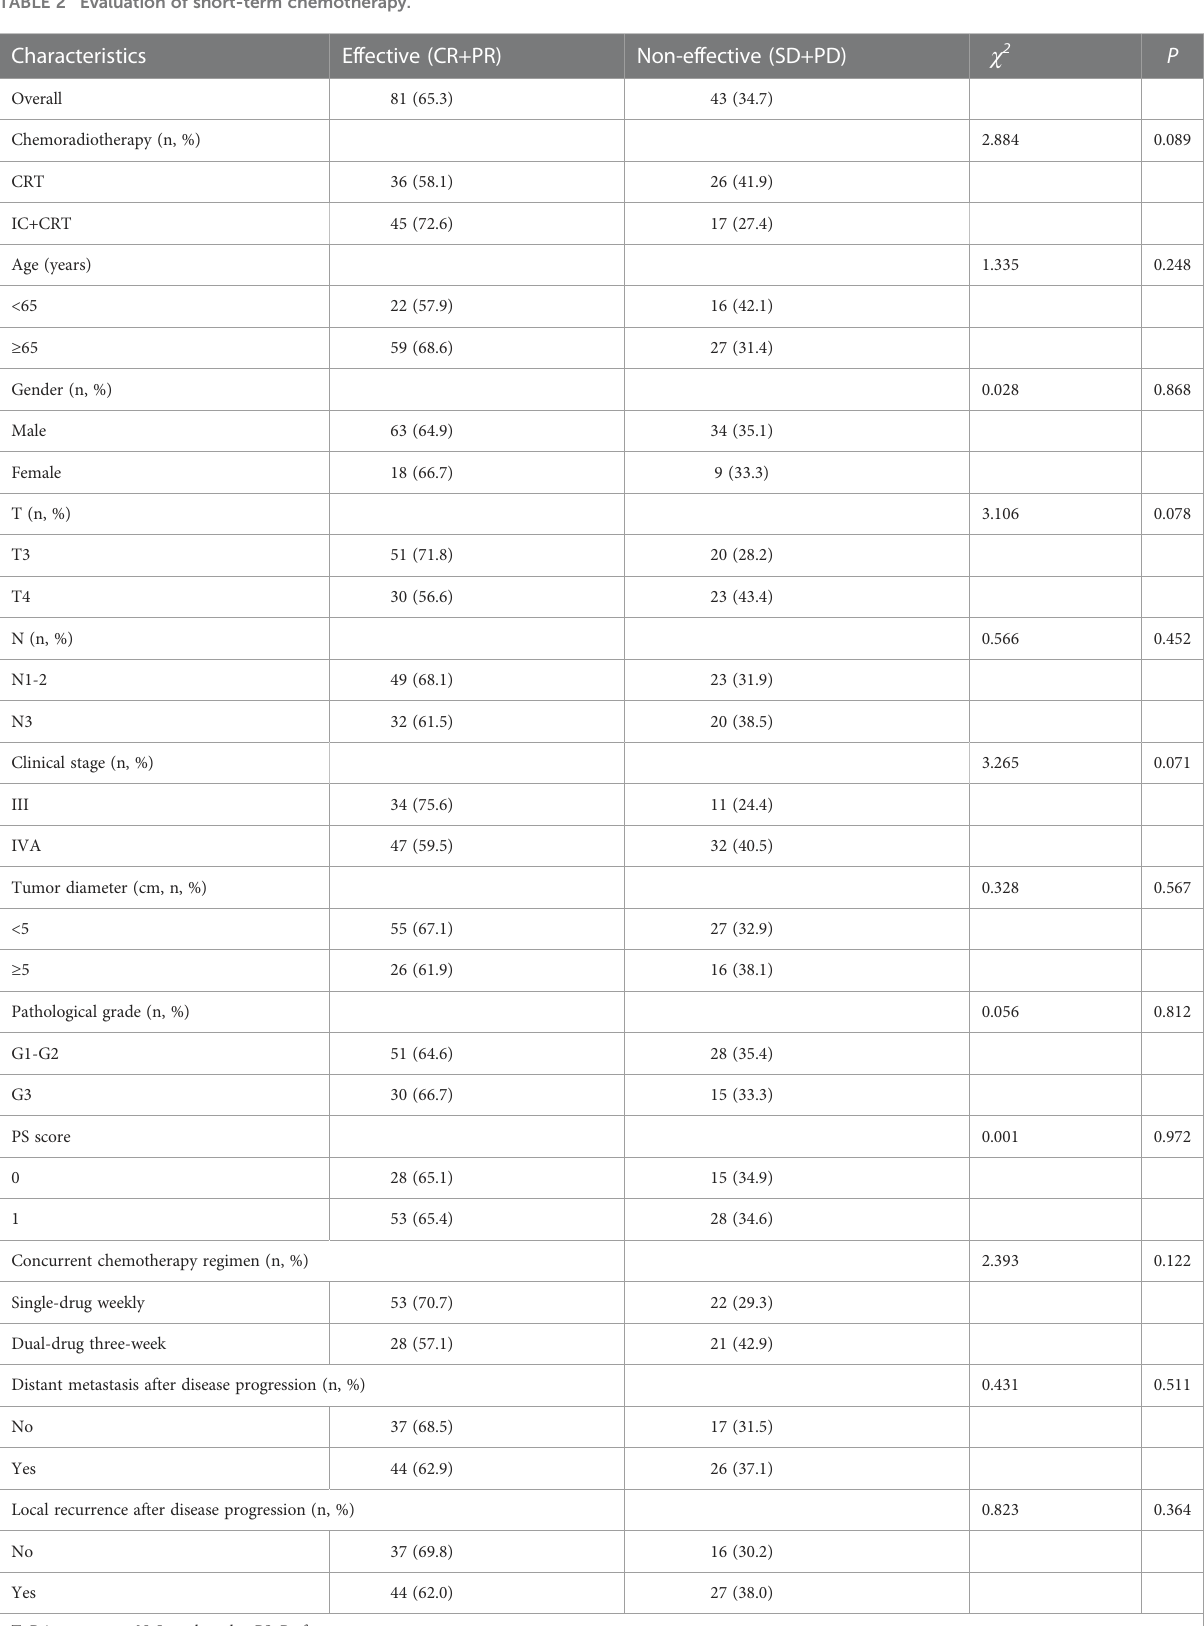
TABLE 2 Evaluation of short-term